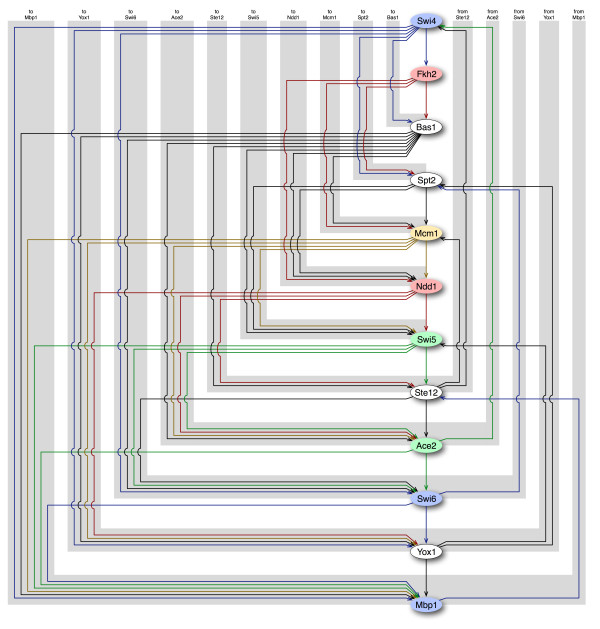
Full network of transcription factors regulating the cell cycle. We identified the 4 transcription factors that were most significantly regulating the cell cycle and considered them along with the 8 canonical factors. We constructed a dynamical model of their α-coefficients and show here the non-zero entries in this matrix as directed links between the 12 factors. The resulting network represents the complete network of couplings between cell cycle regulating transcription factors. A line from factor A to factor B indicates that the activity of A affects the activity of B at the next time point. The displayed order of factors minimizes the number of upward arcs (these arcs being grouped on the right side of the figure).